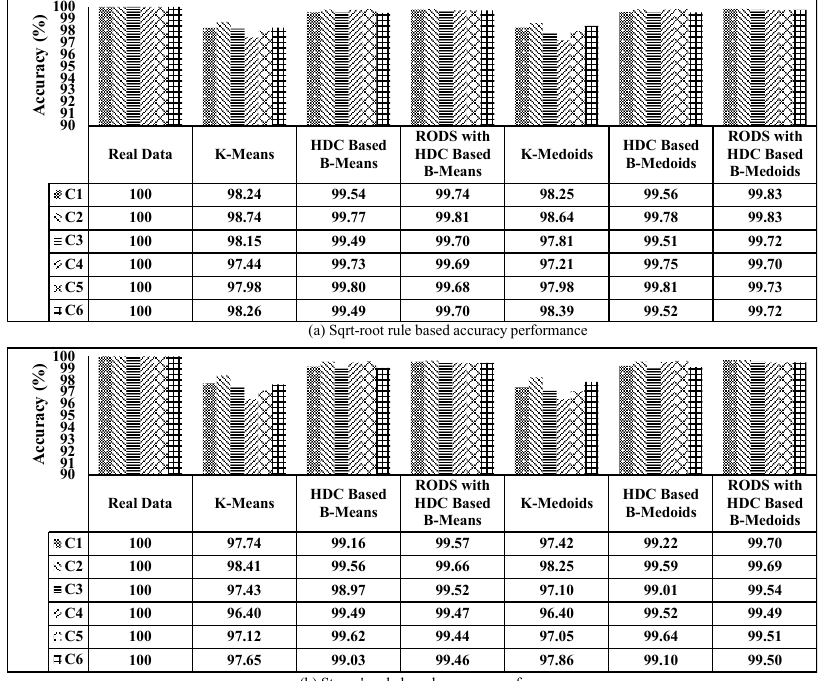
Figure 22. Performance comparison of all evaluated techniques in all selected clusters versus two different rules. ( a ) Accuracy versus all selected clusters based on the square-root rule; ( b ) accuracy versus all selected clusters based on Sturge’s